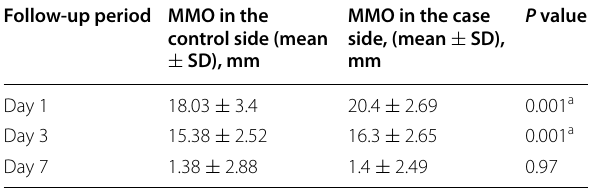
SD standard deviation a Statistically significant